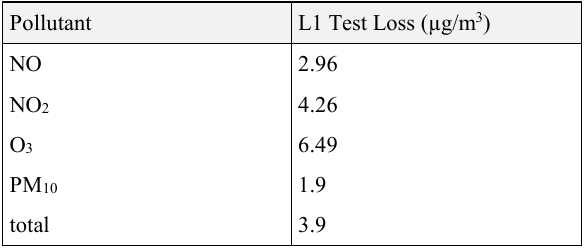
Table 2. Explored parameters of the network and the training